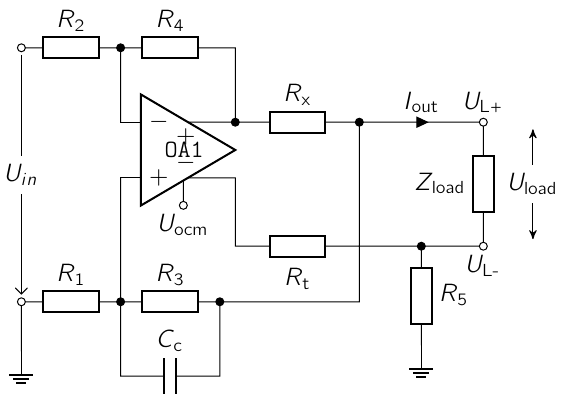
Figure 1: Circuitry of a symmetrical Enhanced Howland Current Source, adapted from [8]. The typical EHCS consists of R 1 to R 4 and R x . The symmetric signal is generated by the negative output of OP1 over R t . R 5 mimics the current flowing through R 1 and R 3 .